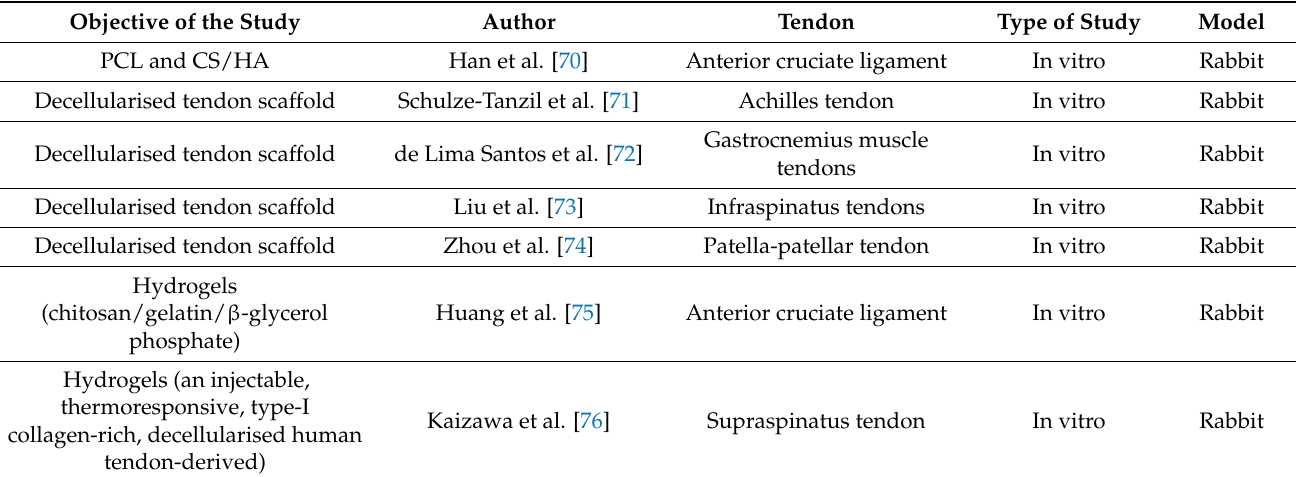
Table 4. Summary of clinical studies using biomaterial scaffolds for tendon